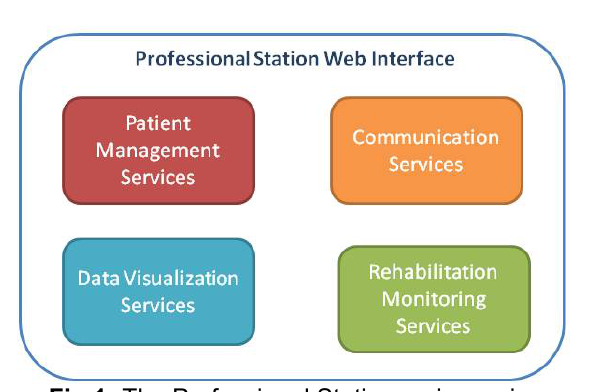
Fig.1: The Professional Station main